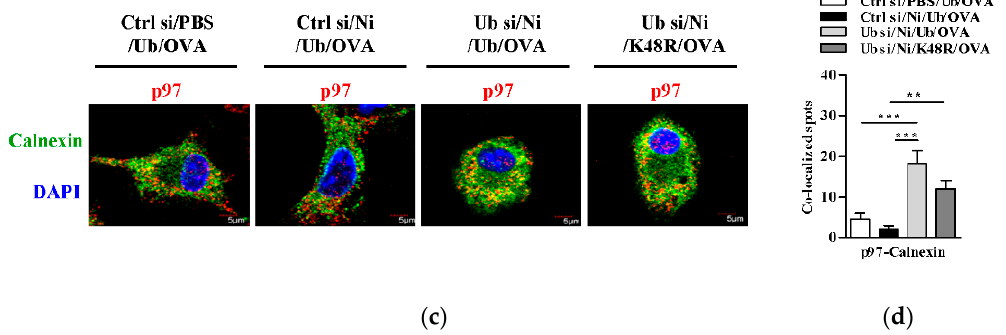
Figure 5. K48-linked ubiquitination is essential for nicotine-augmented endosomal relocation of p97 in bone marrow- derived dendritic cells. ( a , b ) Murine ubiquitin-deficient and control BM-DC were stimulated with nicotine (10 − 7 mol/L) for 12 ~ 16 h. Then, the cells were replenished with K48R-Ub or WT-Ub (30 × 10 − 6 mol/L) and further incubated with ovalbumin (50 µg/mL) for 5 ~ 6 h. The endosomal relocation of p97 ( a ) from the endoplasmic reticulum ( b ) was determined by confocal microscope with EEA1, calnexin, and p97 antibody staining. EEA1 ( a ), calnexin ( b ) were stained green; p97 was stained red; nuclei were counterstained with DAPI (blue). The co-localized spots of p97 with EEA1 ( c ) and p97 with calnexin ( d ) were counted and analyzed. Data are presented as the mean ± SEM, ** p < 0.01, *** p < 0.001, one-way ANOVA with Newman-Keulspost test. One representative from three independent experiments is shown. EEA1: early endosome marker; Calnexin: endoplasmic reticulum marker; Ni: nicotine; Ub: ubiquitin; si: siRNA; OVA: ovalbumin.